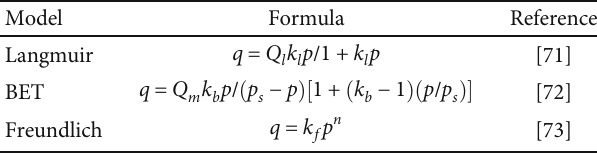
Figure 3: Adsorption isotherm (excess sorption vs. pressure) for (a) CH Brazil at a temperature of 45 ° C [29]. Table 1: Typical models for monolayer and multilayer adsorption.